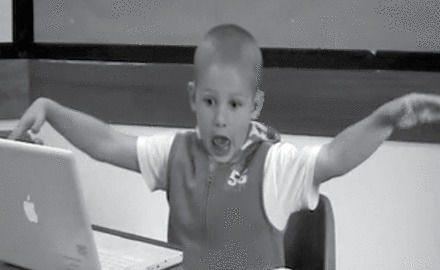
CA predicate where the signer’s body (head, face, arms, and torso) represent Wallace balancing on a train.